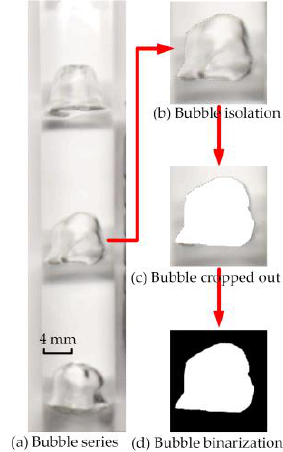
Figure 8. Cut out bubbles and its binarization. ( a ) Bubble series; ( b ) Bubble isolation; ( c ) Bubble cropped out; ( d ) Bubble binarization.